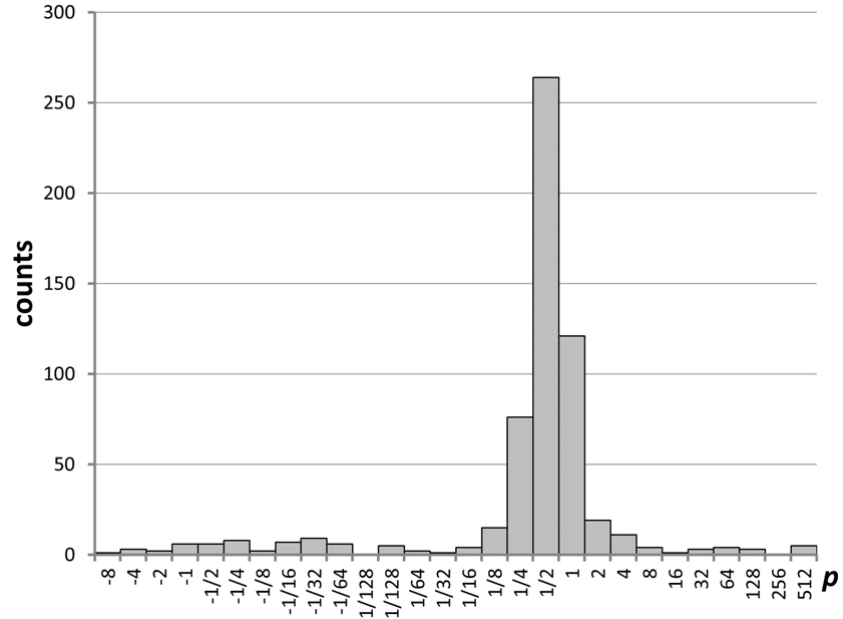
Figure 7. Distribution of optimal values of the Box–Cox transformation parameter p obtained in a 10,000-trials